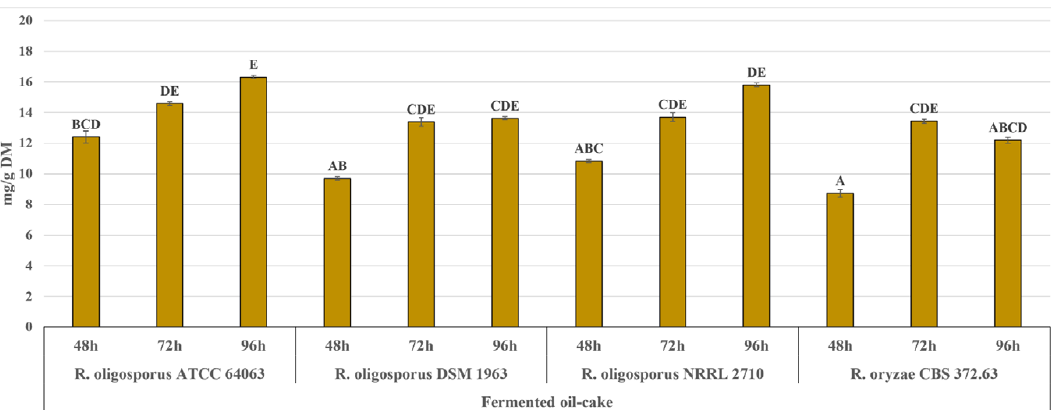
Figure 4. Glucosamine in pumpkin oil-cake fermented with Rhizopus strains. One-way analysis of variance and Tuckey post-hoc test were applied. Data is shown as the mean ± SEM. Different letters depict data that differ significantly ( p ≤ 0.05 ).